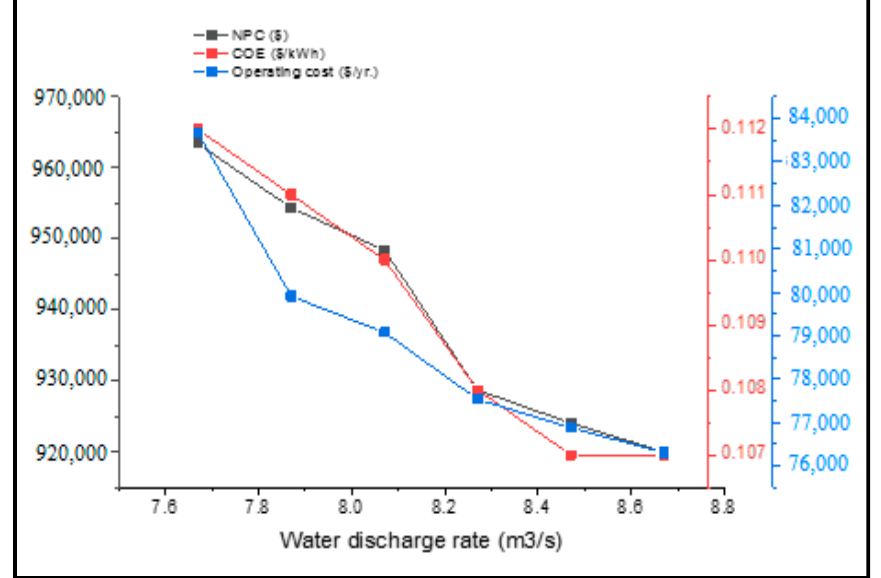
Figure 13. Effect of global solar irradiation (GSI) on the NPC, COE, and operating cost of the HES.